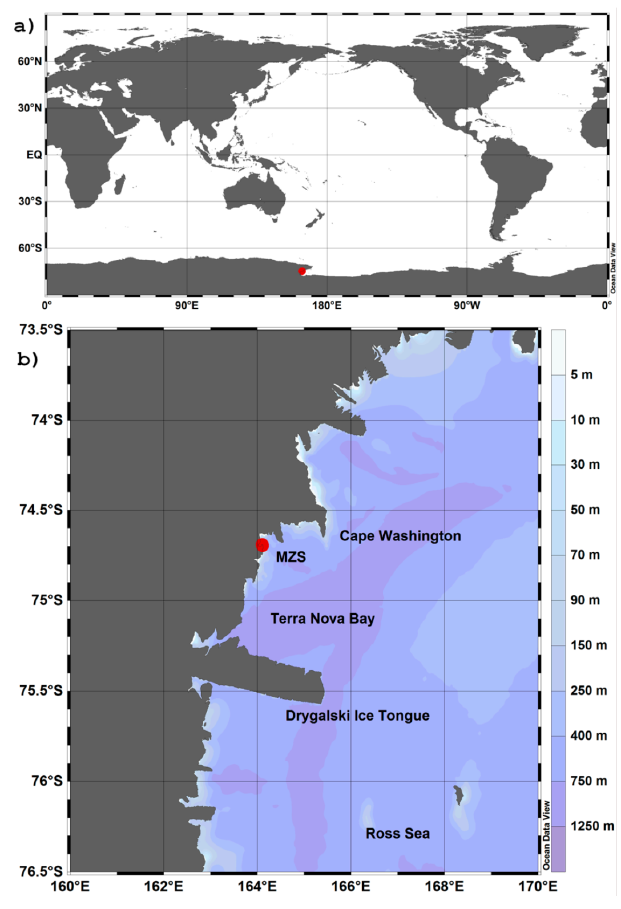
Figure 1. Study area. ( a ) General view illustrating the positioning of the study area (red dot). ( b ) A zoomed view of Terra Nova Bay (within the Ross Sea), location of the experimental site, where the underwater observatory was mounted, close to Mario Zucchelli Station